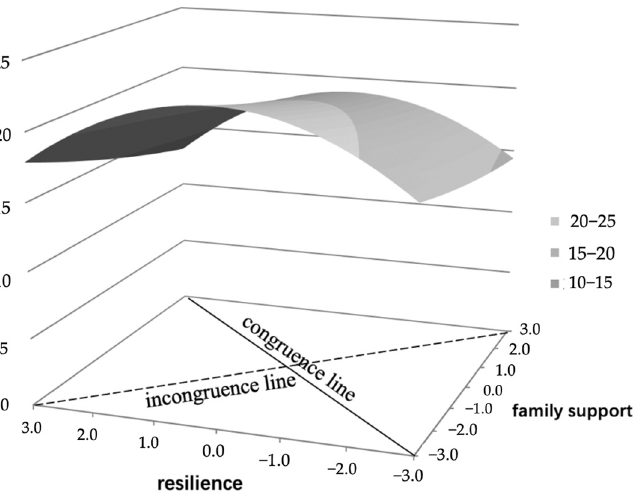
Figure 1. Response surface graphs showing psychological distress predicted by resilience and family support.